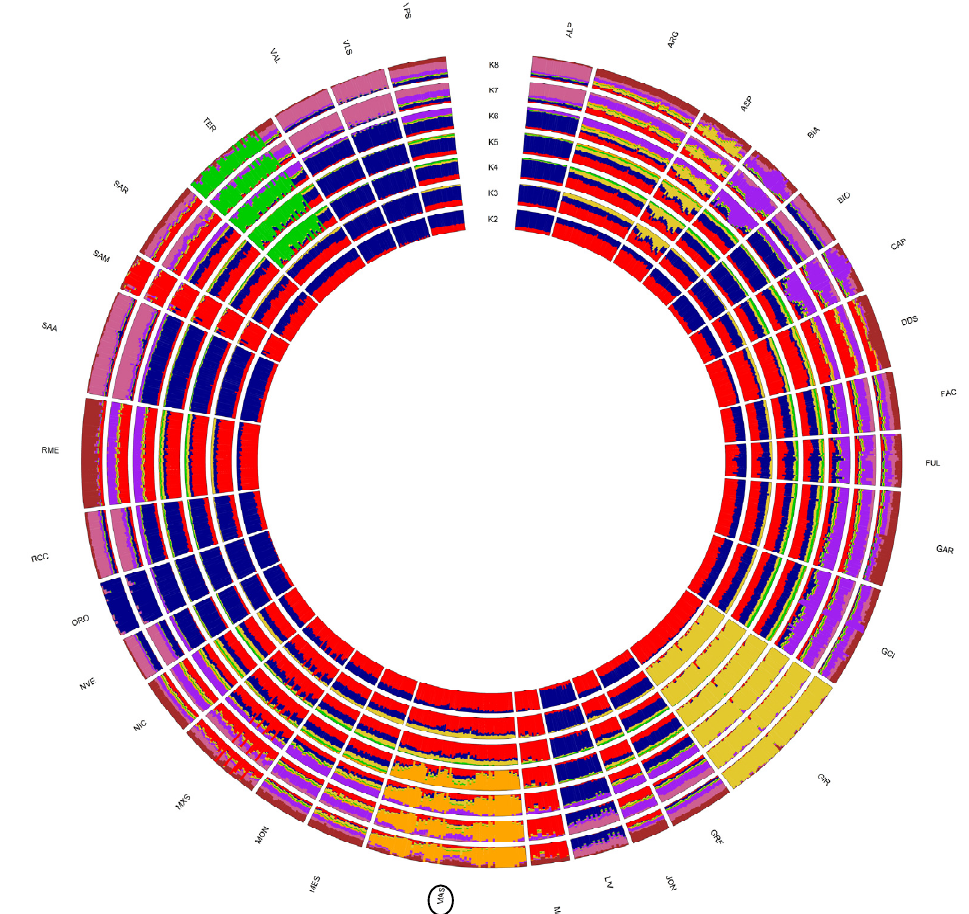
Figure 6. Population structure for 32 goat populations inferred from the ADMIXTURE analysis with K values from 2 through 8. For the full definition of populations, see Table 1 (Mascaruna = MAS).